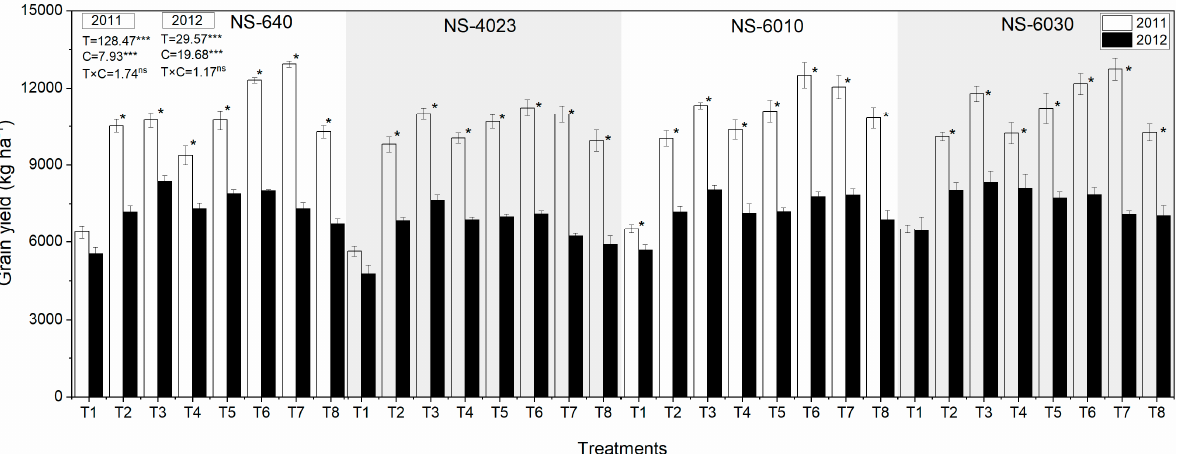
Figure 2. Fertilization effects on grain yield (kg ha − 1 ) four maize cultivars over two years. Bars show mean values of four replicates and contain standard errors of means (n = 4). For ANOVA analyses, *** show significant treatment (T), maize cultivar (C) and their interaction effects at p < 0.001, respectively. Each pair of bars with asterisk (*) show significant difference in grain yield between 2011 and 2012 years at P < 0.05. ns = non-significant effects. T1: P 60 K 60 ; T2: P 60 K 60 + N min spring ; T3: P 60 K 60 + N 40autumn + N min spring ; T4: P 60 K 60 + N 60spring ; T5: P 60 K 60 + N 100spring ; T6: P 60 K 60 + N 40autumn + N 60spring + Zn; T7: